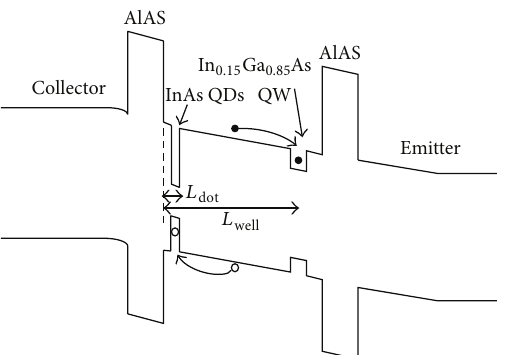
Figure1:Schematicdiagramofthecapturingofanelectronandhole photoexcited in a QW and QD under bias.